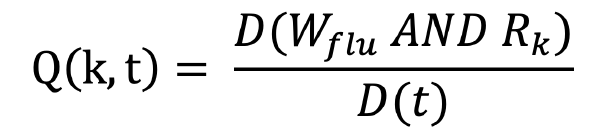
selected by the word embeddings were converted into time-series data by the following